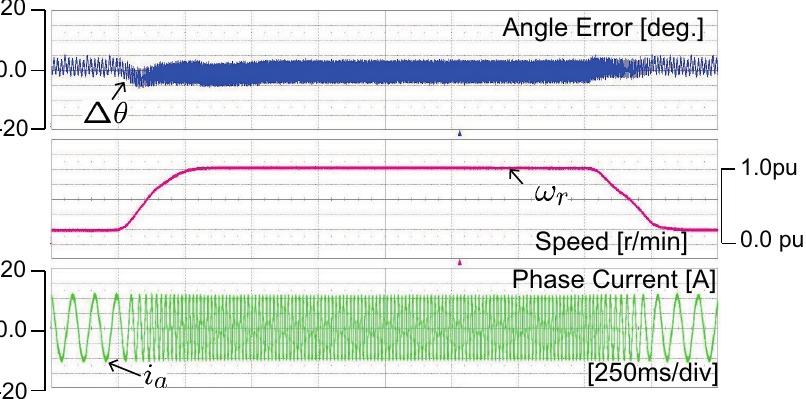
Figure 13. Speed transition from 400 r/min to 2000 r/min (1.0 pu) under the rated